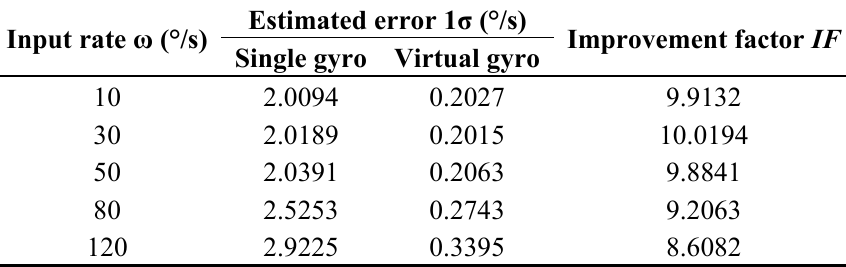
Table 4. Constant rate test results of virtual gyroscope.